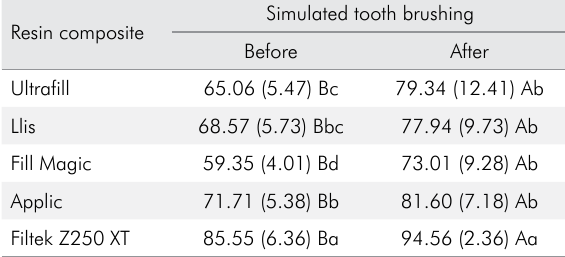
Table 2. Mean and standard deviation (SD) of Knoop Microhardness (KNH) before and after simulated tooth